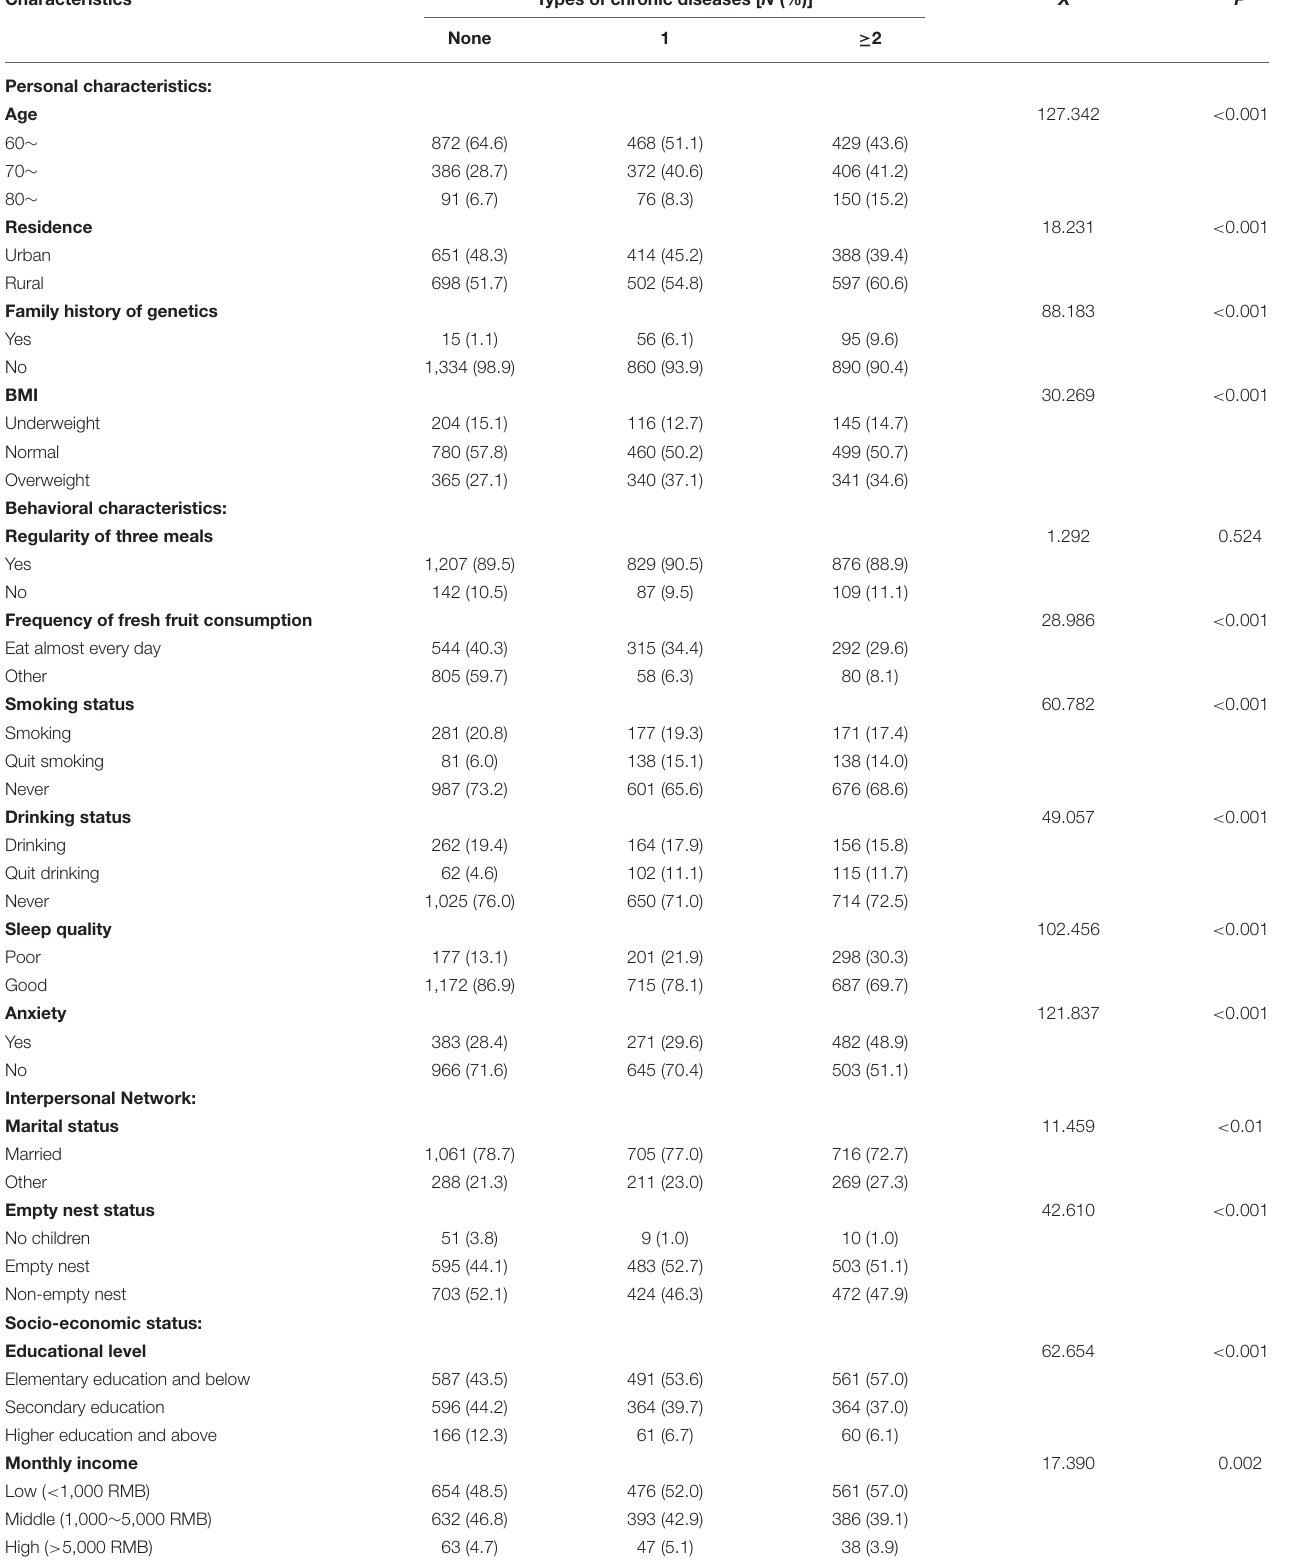
TABLE 4 | Comparison of the types of chronic diseases among older adults. Characteristics Types of chronic diseases [ N